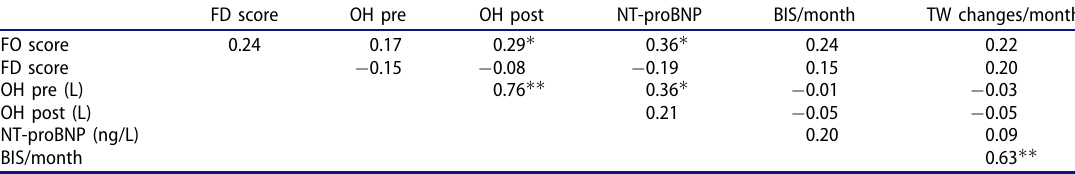
Table 5. Correlations in entire